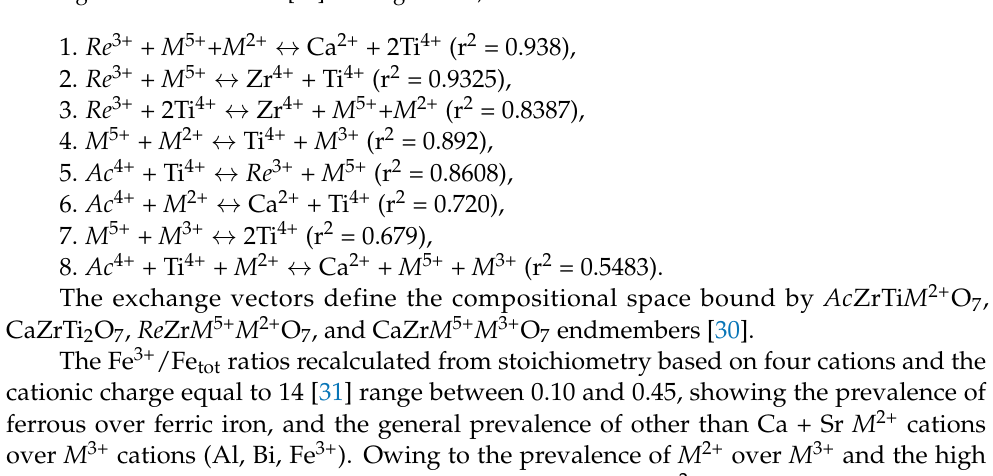
Figure 10. Important substitutions in zirconolites from Hajná č ka. Substitution numbers refer to exchange vectors defined in [27] and Figures 11a,b.